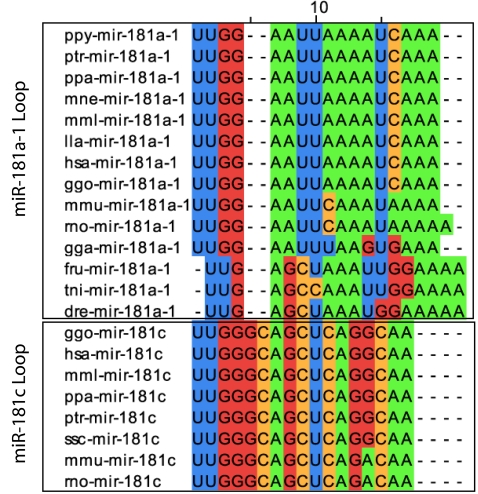
Phylogenetic comparison of pre-miR-181a-1 and pre-miR-181c loop sequences.The full genus and species names and their abbreviations are as follows: Danio rerio, dre; Fugu rubripes, fru; Homo sapiens, hsa; Gallus gallus, gga; Gorilla gorilla, ggo; Lagothrix lagotricha, lla; Macaca mulatta, mml; Mus musculus, mmu; Macaca nemestrina, mne; Pan paniscus, ppa; Pongo pygmaeus, ppy; Pan troglodytes, ptr; Rattus norvegicus, rno; Sus scrofa, ssc; Tetraodon nigroviridis, tni.